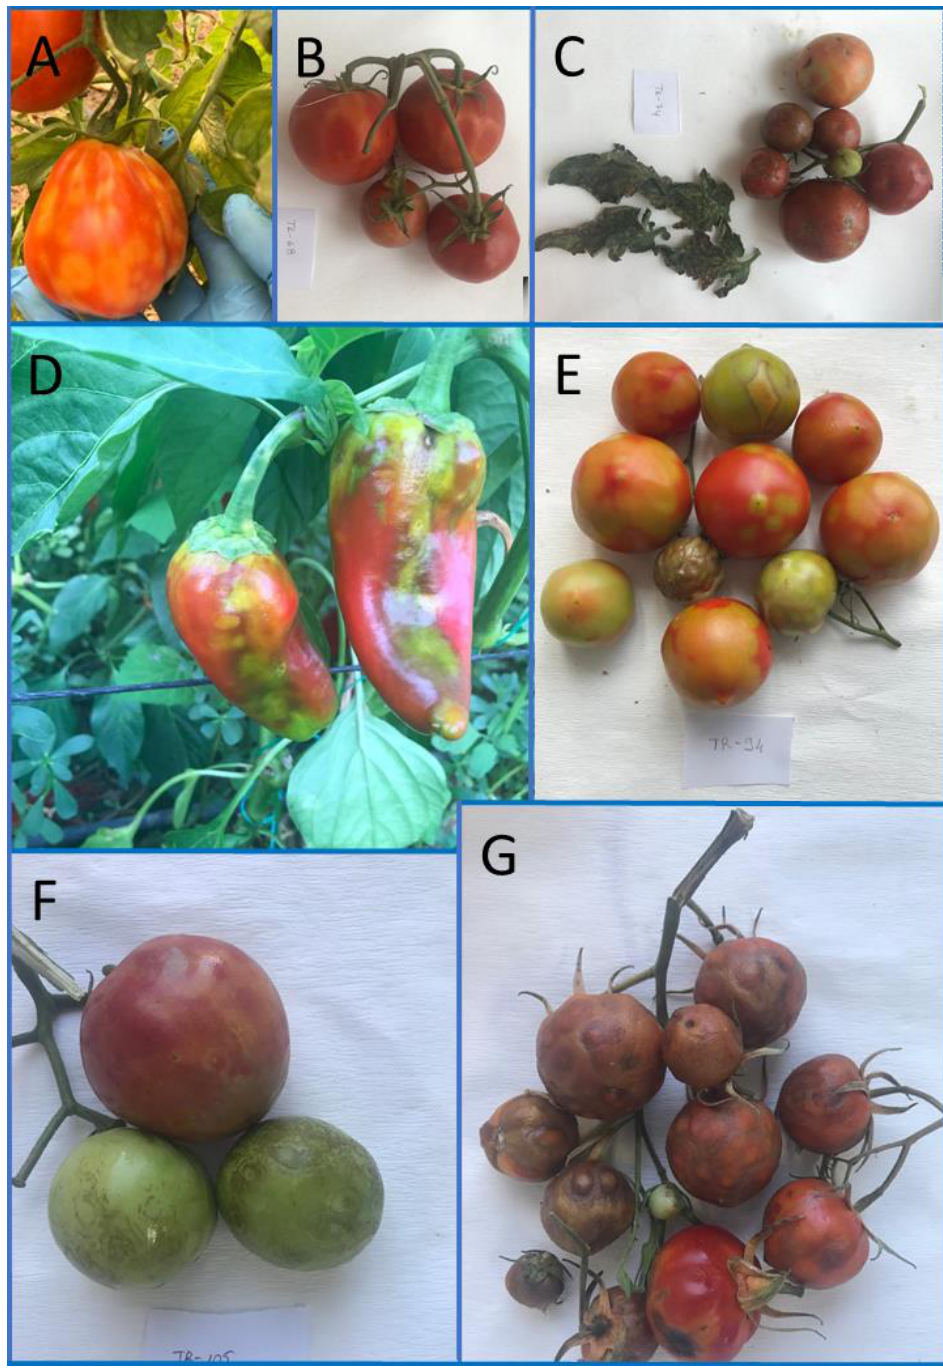
Figure 1. Different symptoms on plants infected by ToBRFV Turkish isolates. ( A ) Spots on fruit and leaf mosaic on tomato infected by TR-49; ( B ) spots on tomato fruits infected by TR-68; ( C ) leaf and fruit malformation on tomatoes infected by TR-74; ( D ) yellow spots and severe malformation on peppers infected by TR-79; ( E ) spots and blisters on tomato fruits infected by TR-94; ( F ) spots on tomato fruits infected by TR-105; and ( G ) severe blisters on tomato fruits infected by TR-108. Phylogenetic analysis of the ORF4/CP alignment of 185 isolates by MEGA X sug- gested that ToBRFV phylogeny can be divided into three groups (Figure 2). The